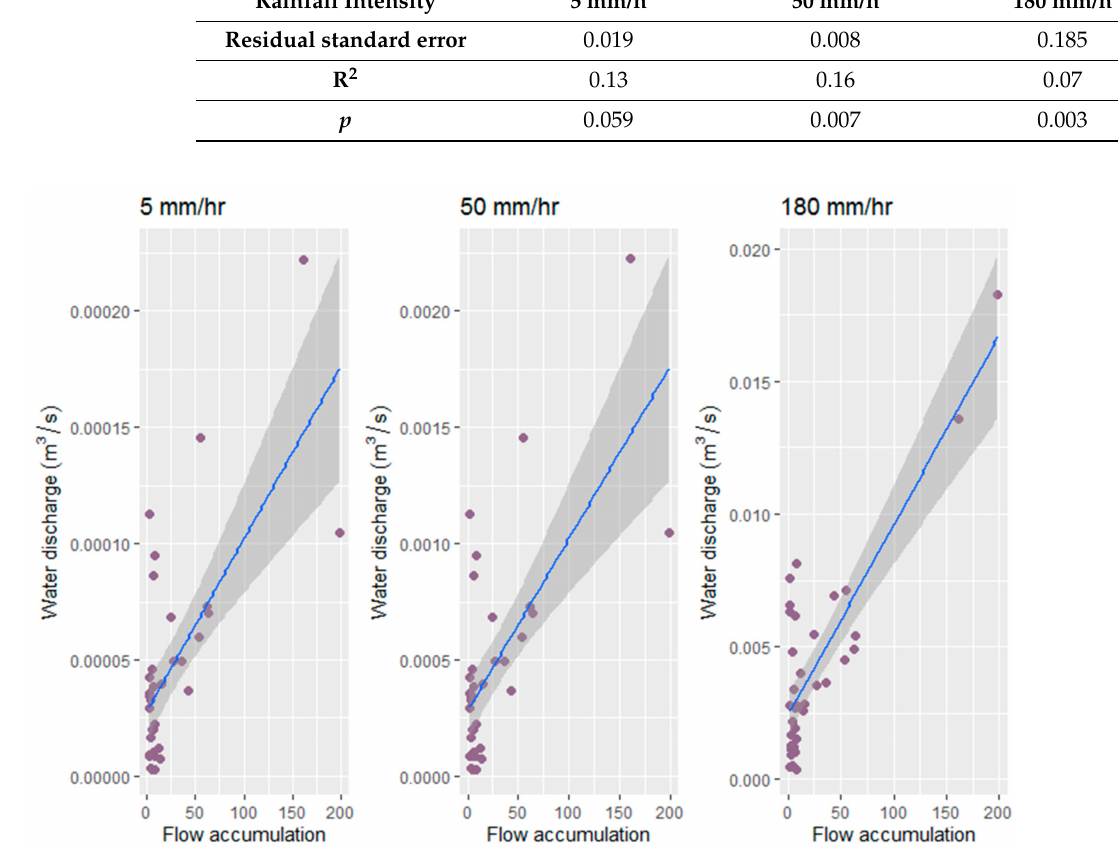
Figure 11. Scatter plots and linear regression for water discharge versus flow accumulation for three precipitation intensities. See Table 3 for the correlation coefficients. While in 5–50 mm/h simulation water discharge has similar increase of intensity (10 times), in 50–180 mm/h comparison, water discharge shows a reduction of